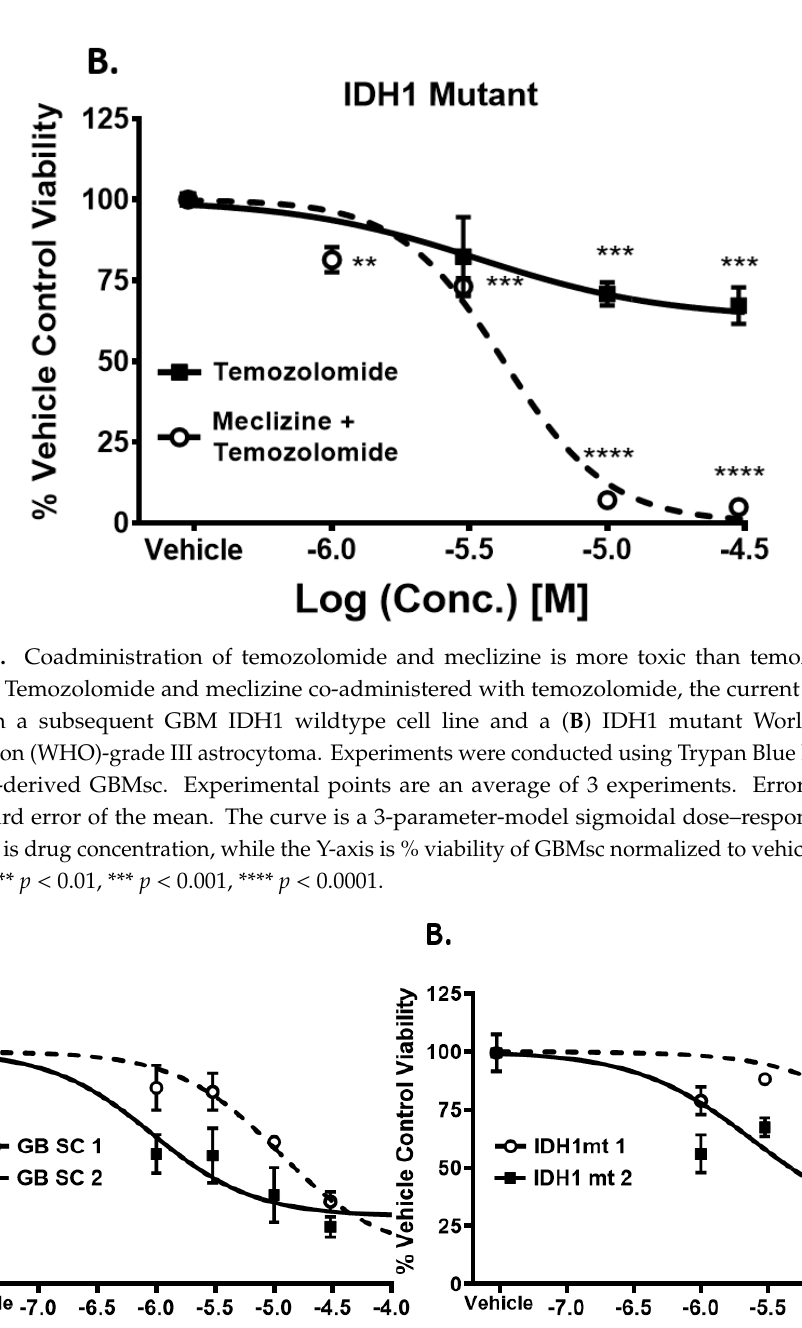
Figure A3. GBMSCs have appropriate stemness markers. Western Blot showing stemness of cells used in manuscript. 0827 and 0923 refer to IDH1 wt 1 and IDH1 wt 2, respectively. NBE refers to the cells in the “stem” state, and “Diff” refers to the cells after ten days of culture in media containing 10% FBS. Cells were in the “NBE” or “stem” state for all experiments presented in the manuscript. Molecular markers for stemness included are sox2 and Nestin. Markers of differentiation are TUJ-1 and GFAP. Actin served as the loading control.